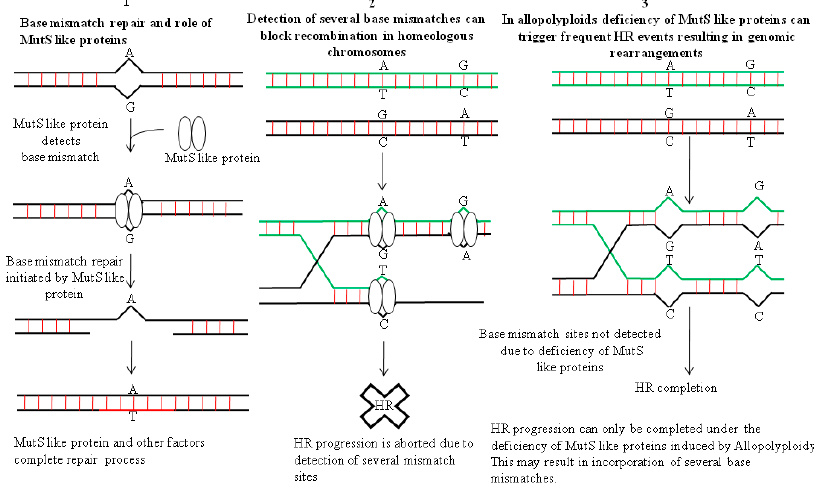
Figure 1. Recombination events in allopolypoids can happen frequently due to mismatch repair